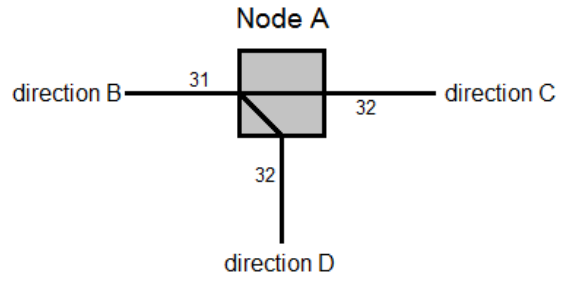
Figure 13. Alternative routing of freight trains (al- ternative train paths – from A either to C or D).